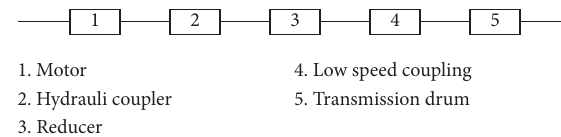
Figure 6: Algorithm flowchart of objective function.